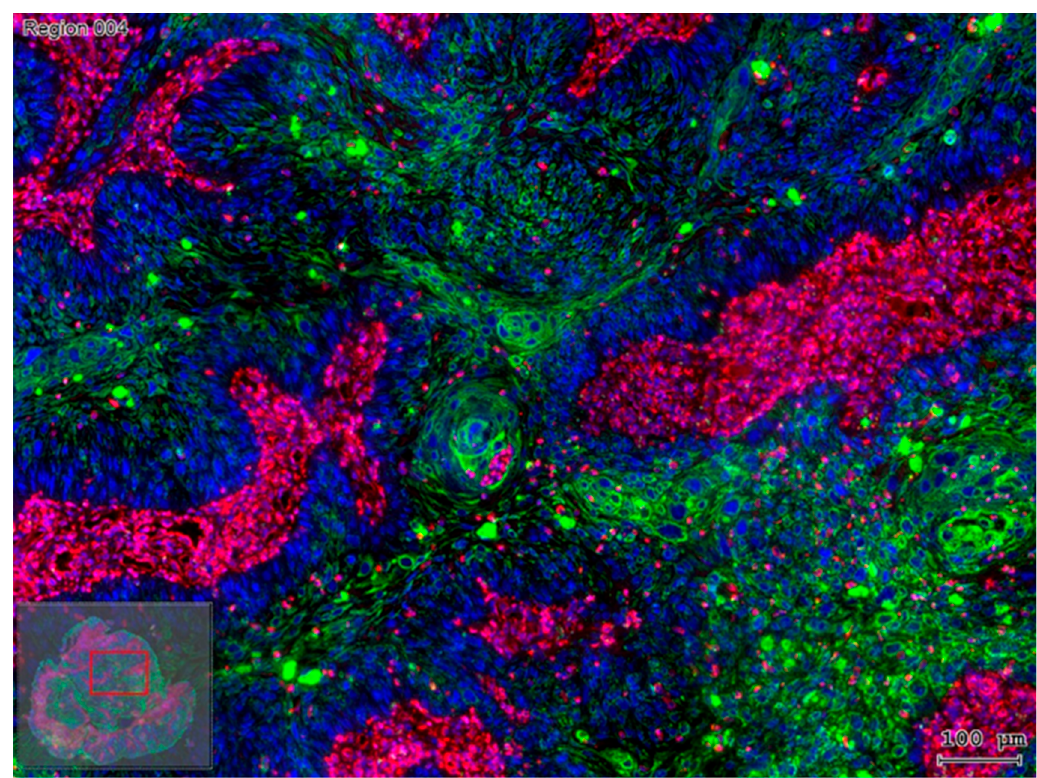
Figure 3. Vimentin represents an extended fibroblastic component in a primary oral squamous cell carcinoma (OSCC). Tissue section of human OSCC with the detection of vimentin (magenta) and pan-cytokeratin (green) and cell nuclei counterstained with DAPI (blue). Tumor cells form nests with a decreasing representation of the epithelial differentiation marker pan-cytokeratin from the middle of the tumor cell nests to their border. Among the tumor cell nests, the stroma contains large amounts of vimentin + fibroblasts. This image was taken by the TissueFaxs TM system (Tissuegnostics Vienna), and the bar represents 100 µm.